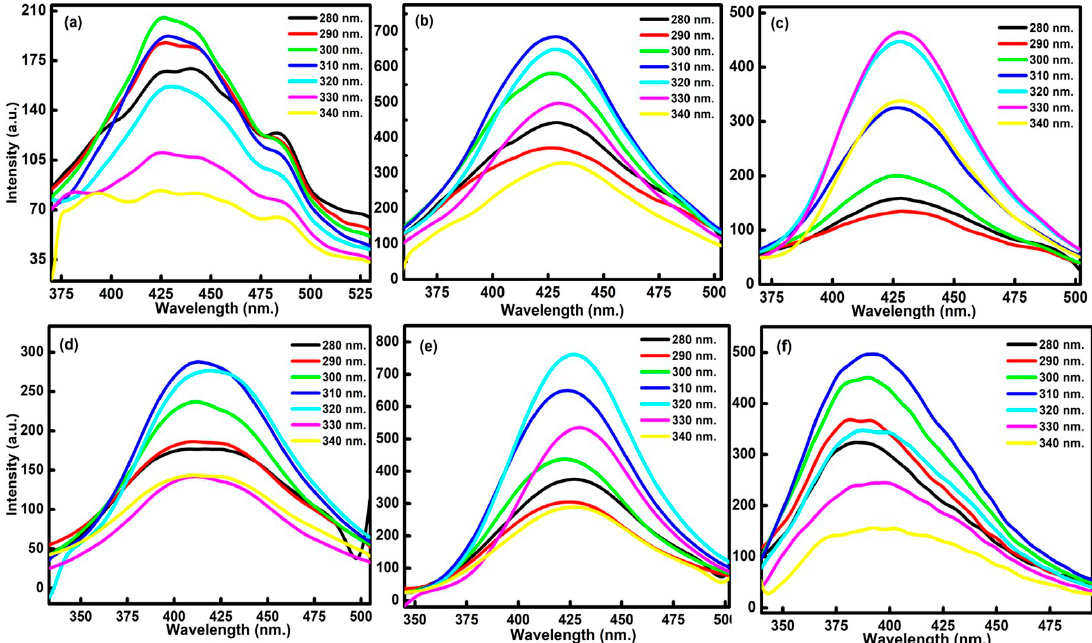
Figure 5. Excitation wavelength-dependent fluorescence spectrum of ( a ) P@C-dots, ( b ) C@C-dots, ( c ) B@C-dots, ( d ) P@ACs, ( e ) C@ACs and ( f ) B@ACs ranging from 280 nm to 340